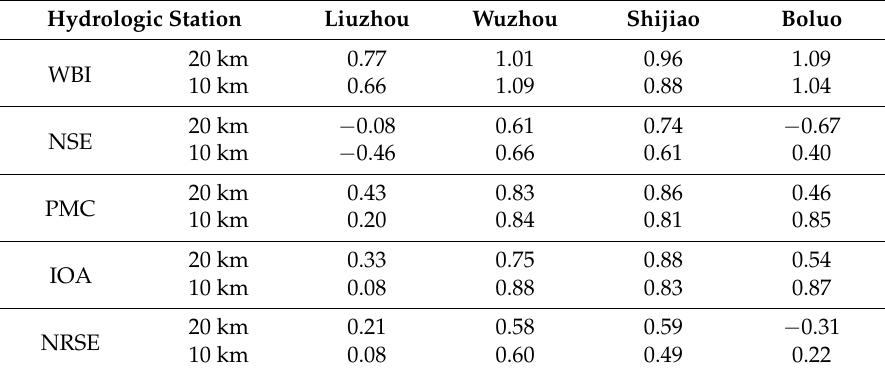
Table 4. Evaluation of hydrological extreme simulation in